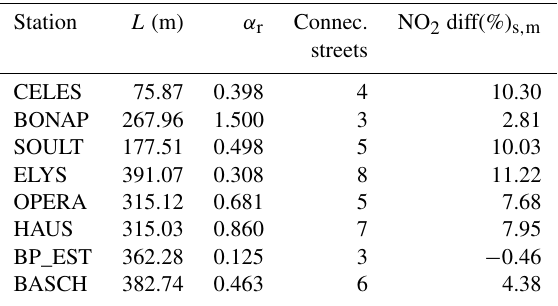
Table 7. Street length ( L ), aspect ratio ( α r ), number of connected streets, and the corresponding relative difference of NO 2 concentra- tions calculated by SinG and MUNICH at each traffic